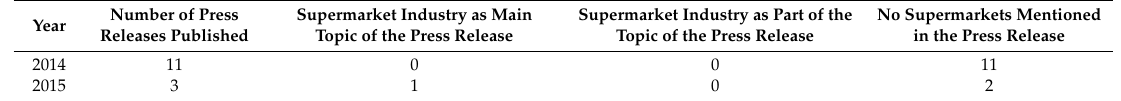
Table 2. Analysis of press releases by Action on